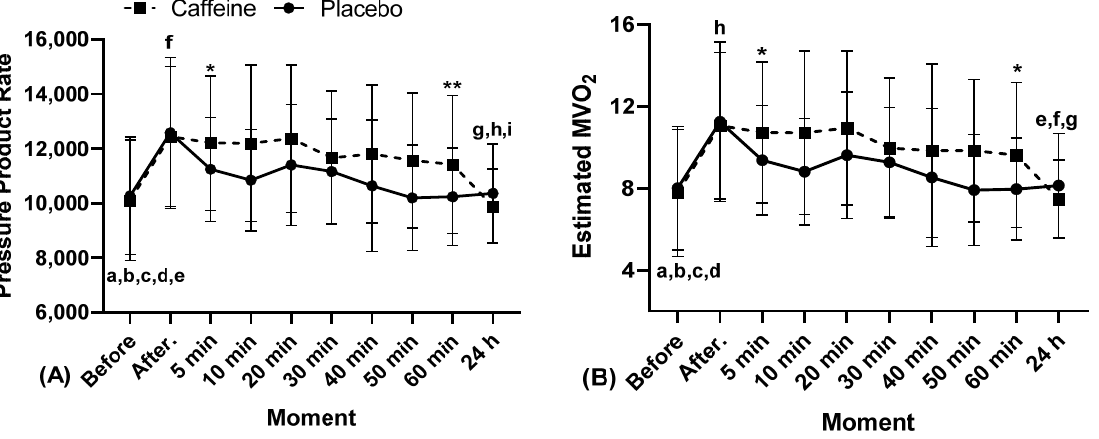
Figure 4. Cardiovascular response after resistance exercise with caffeine and placebo in relation to pressure product rate and estimated myocardial oxygen volume, at different times, min: Minutes, h: Hours. “*”, and “**” indicate interclass, and “a”, “b”, “c”, “d”, “e”, “f”, “g”, “h” and “i” indicate the intraclass difference.